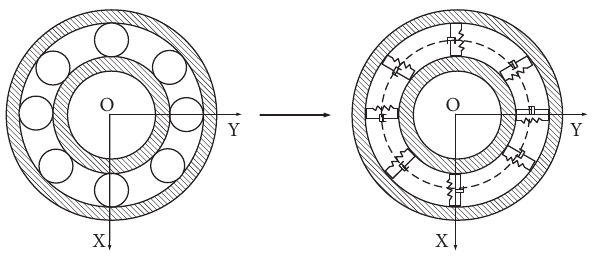
Figure 1: Simplified rolling bearing model.